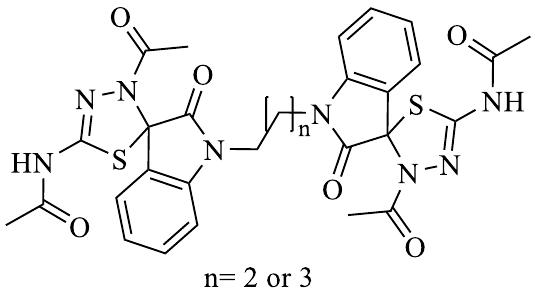
Fig. 5. Isatin derivatives as anti-bacterial activity (da Costa et al., 2021)